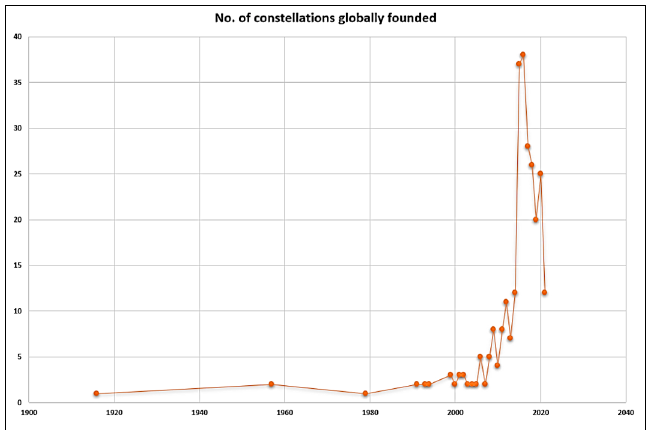
Figure 1. Yearly trend of the satellite constellations.